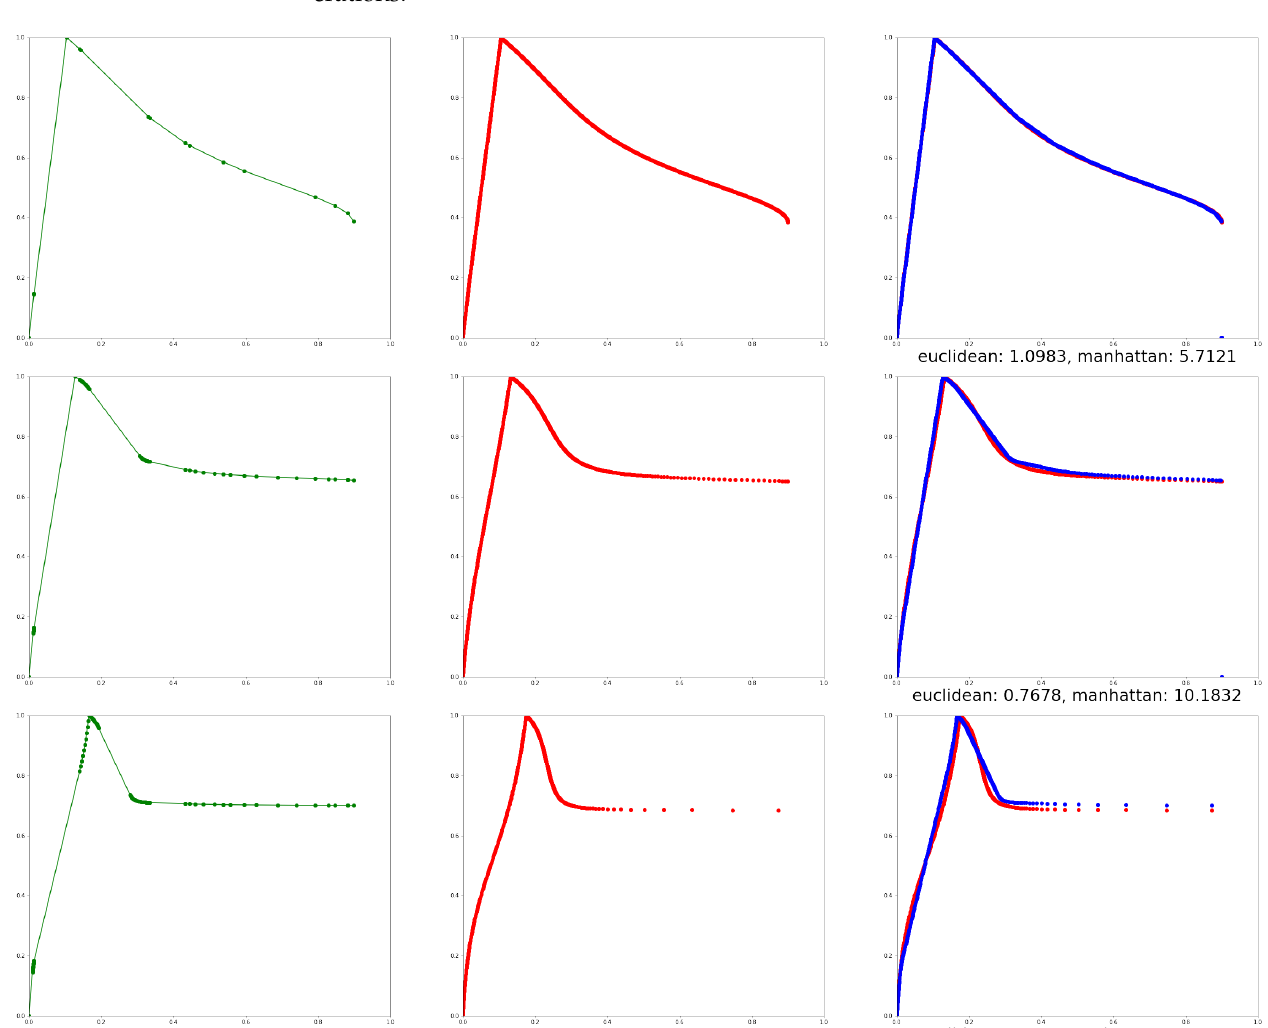
Figure 16. Accuracy of the algorithm—the 1st, 10th, and 25th